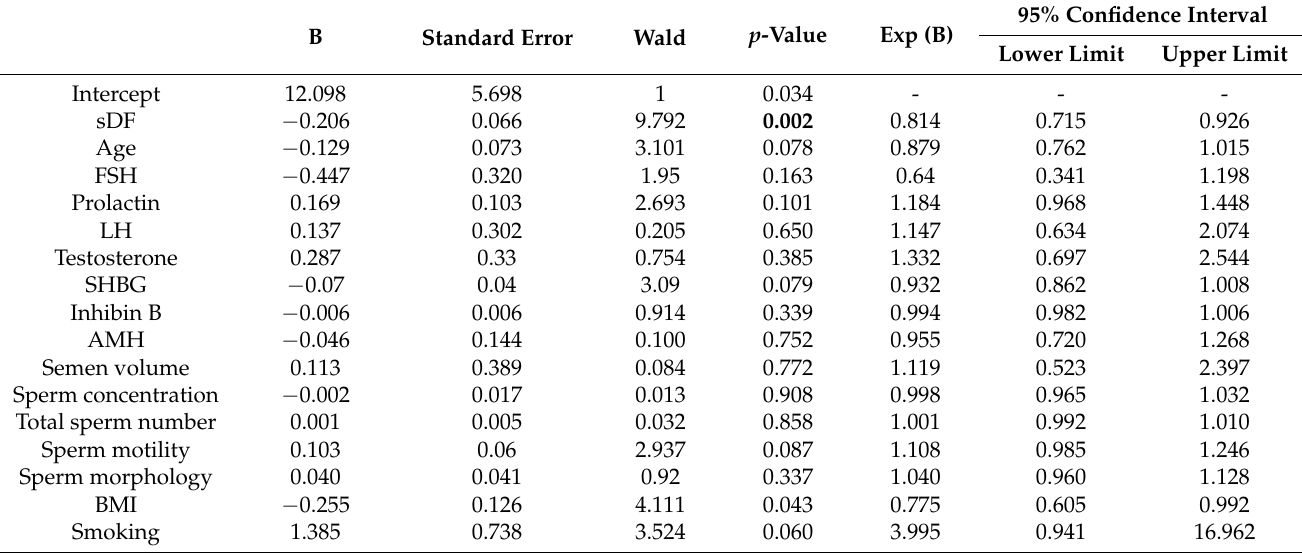
Table 7. Predictive markers: logistic regression analysis performed using sperm DNA fragmentation index improvement as dependent variable and all parameters obtained at baseline as indepen- dent